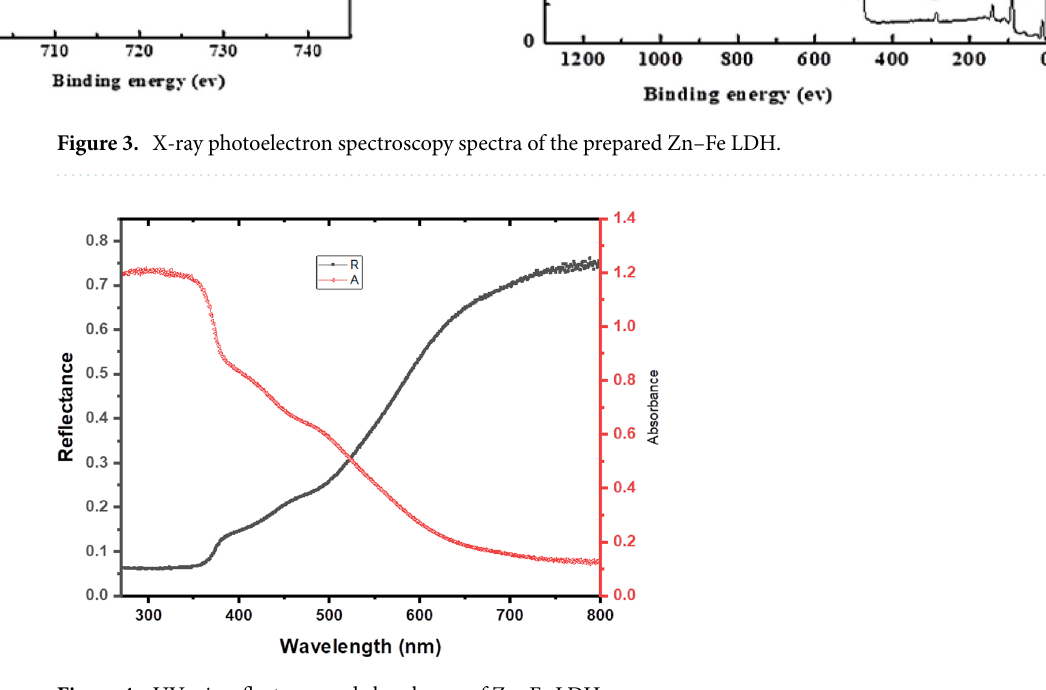
Figure 4. UV–vis reflectance and absorbance of Zn–Fe